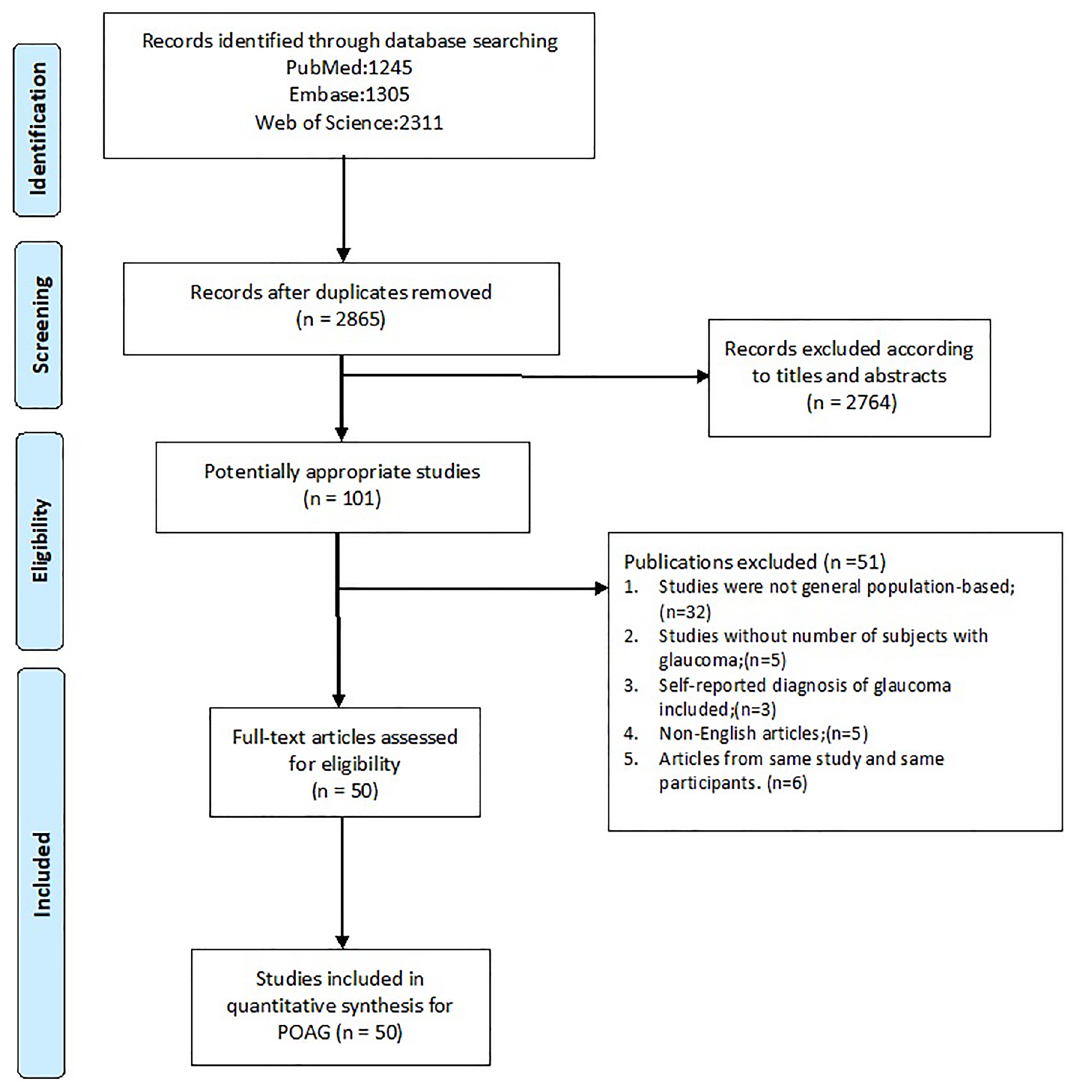
Figure 1. Flow charts of search strategy. The flow chart illustrates the search strategy following the Preferred Reporting Items for guidelines of Systematic Reviews and Meta-analysis (PRISMA) guidelines. POAG primary open-angle